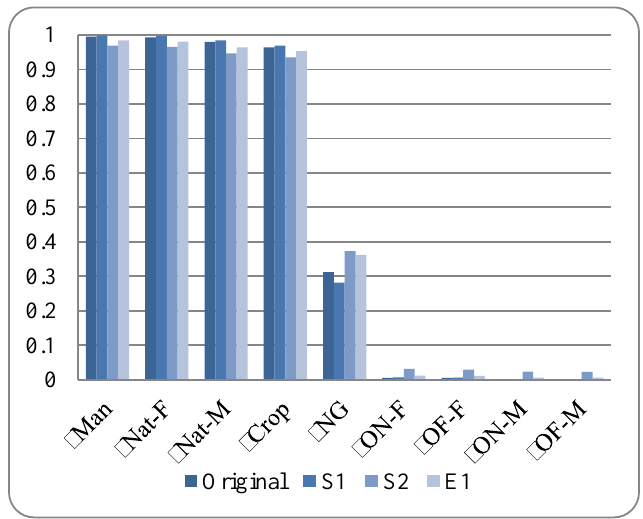
Fig. 5. Sensitivity analysis of weights within TOPSIS, where S1 – society point of view, S2 – stakeholders point of view, E1 – entrepreneurs point of